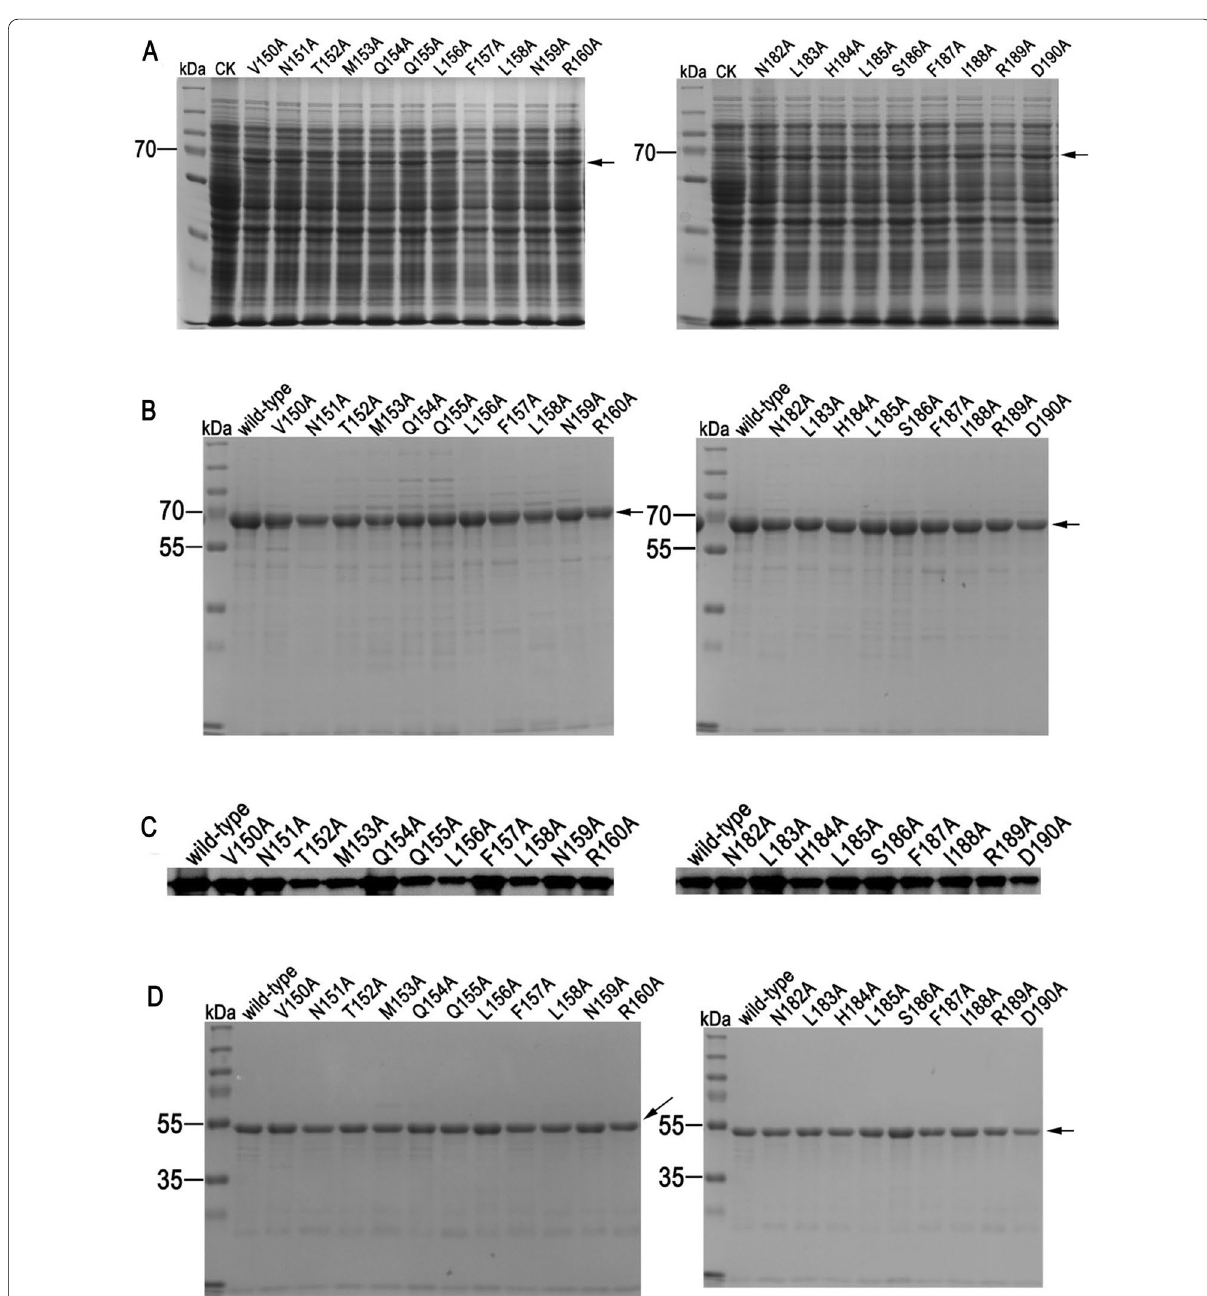
Fig. 2 Expression, purification and identification of Cry2Ab mutants. A Induced expression of Cry2Ab variants. B The purity of Cry2Ab mutants detected by SDS‑PAGE followed by Coomassie blue staining. C Identification of Cry2Ab mutants using an anti‑Cry2Ab antibody. D The proteolytic activation of Cry2Ab mutants by